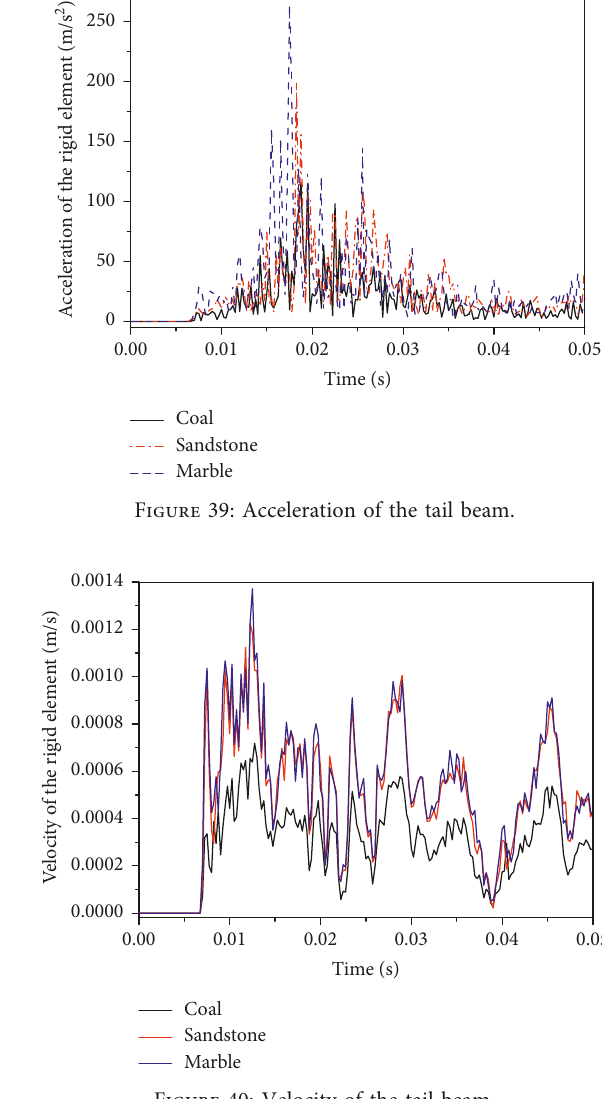
Figure 38: Contact force.